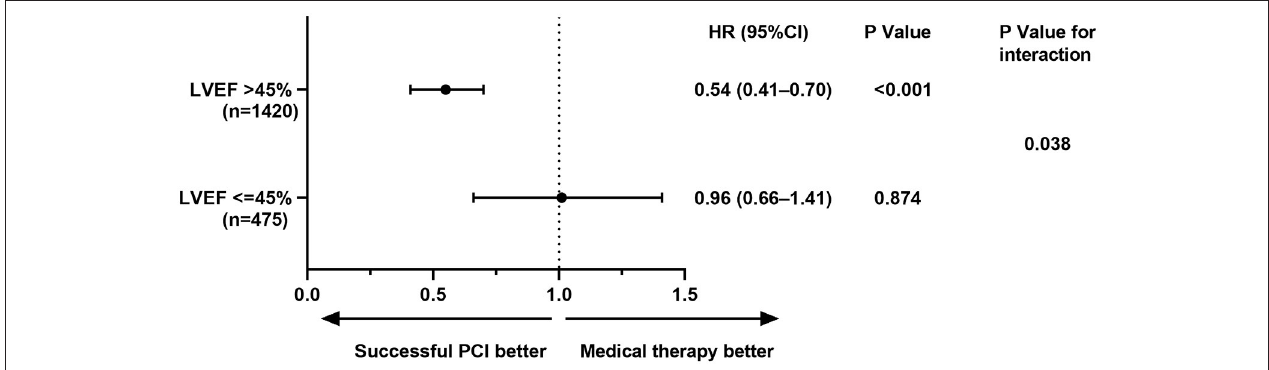
FIGURE 3 | Left ventricular systolic function subgroup analysis for MACE. CI, confidence interval(s); HR, hazard ratio; LVEF, left ventricular ejection fraction; MACE, major adverse cardiovascular events; PCI, percutaneous coronary